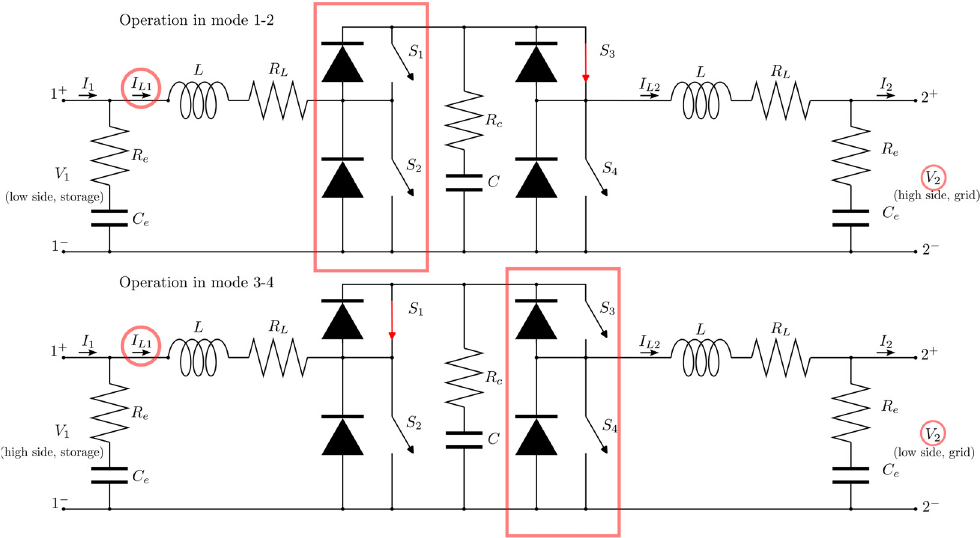
Figure 2. Comparison between operation in Modes 1–2 and 3–4 of the bidirectional Split-pi con-